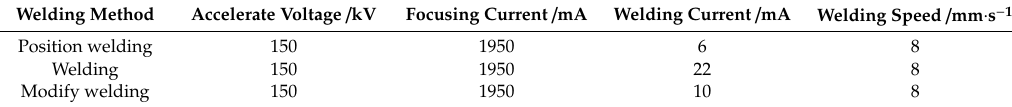
Table 1. Electron beam welding parameters of Ti600 / Ti-22Al-25Nb specimens.